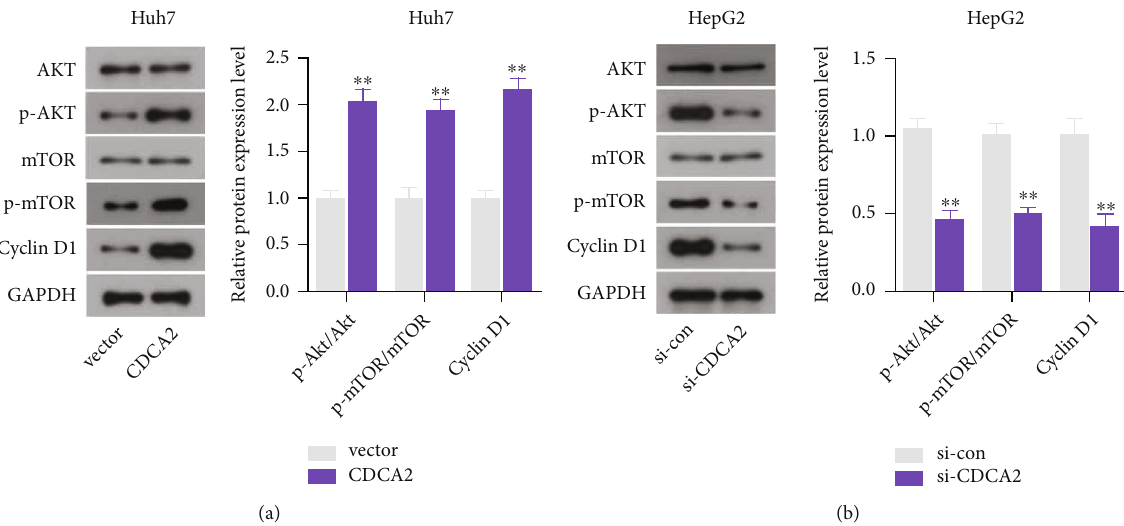
Figure 4: Evaluate the e ff ect of cell division cycle associated 2 (CDCA2) on the expression of key factors. (a) Upregulation of CDCA2 increased the expression of p-AKT, p-mTOR, and Cyclin D1. (b) Exhaustion of CDCA2 inhibited the expression of p-AKT, p-mTOR, and Cyclin D1. ** p < 0 : 01 versus vector or